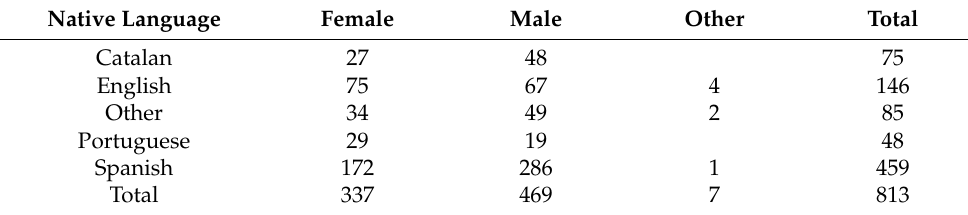
Table 4. Native language by gender on the sample.